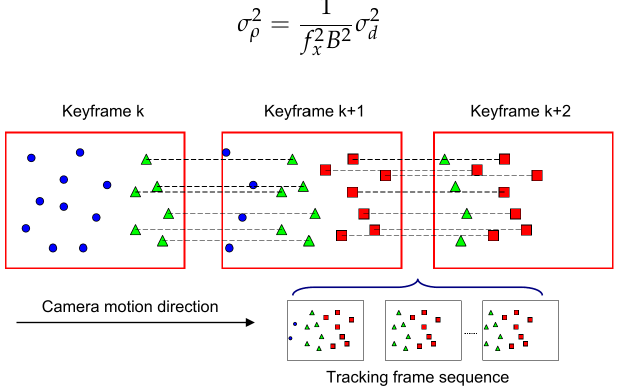
Figure 4. An example for the camera exploration mode. For the k -th key-frame; the blue points indicate the “old” features that have been matched with the map; and green triangles are the new features that await triangulation. For the ( k + 1)-th key-frame, green triangle features can be triangulated, and some new features (red rectangle) wait for the next key-frame for triangulation. Between the ( k + 1)-th key-frame and the ( k + 2)-th key-frame, there is a set of tracking frames that also can provide useful measurements for the new features (red rectangle); we integrate all of the multi-view observations for the new feature using an inverse depth